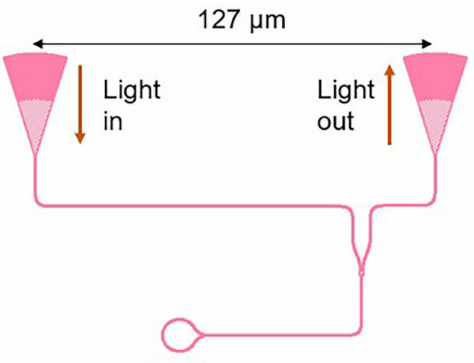
Figure 9. The full layout schematic of the device layout with the input/output component. The SEM image of one of the fabricated devices is shown in Figure 10. The magnifica- tion of the SEM image is 2070 times. The focused image shows the 1D PhC structure which is not visible from the larger scale. The holes’ size used for the PhC in this image is 70 nm radius which can be done with the EBL process.